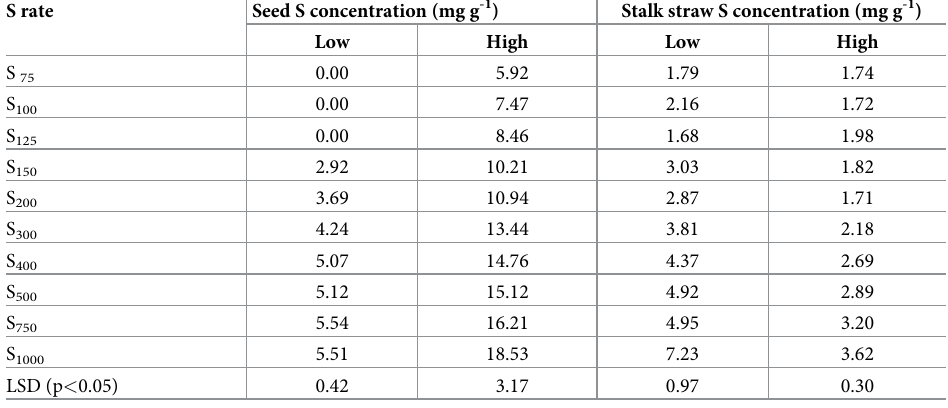
Table 2. Sulfur concentrations in the seed and stalk straw in response to sulfur levels (low = low-GSL line and high = high-GSL